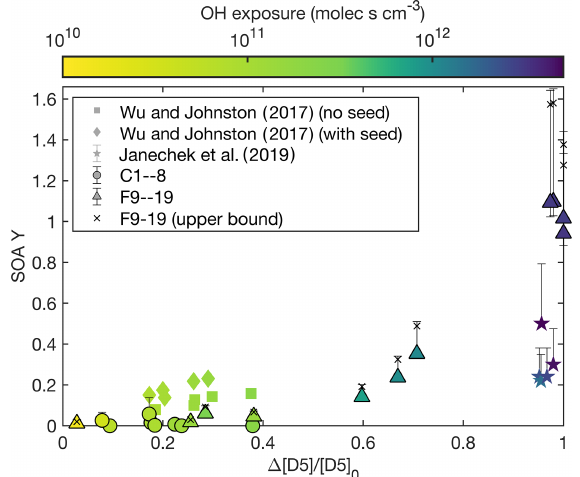
Figure 3. Measured SOA yield as a function of the fraction of D5 reacted at the end of the experiment. The color of each point indi- cates the OH exposure for the experiment. Experiments performed here are circles and triangles and are outlined in black, those by Janechek et al. (2019) are stars, and those by Wu and Johnston (2017) are squares and diamonds. The wall-deposition-corrected data for F9–19 are shown as black